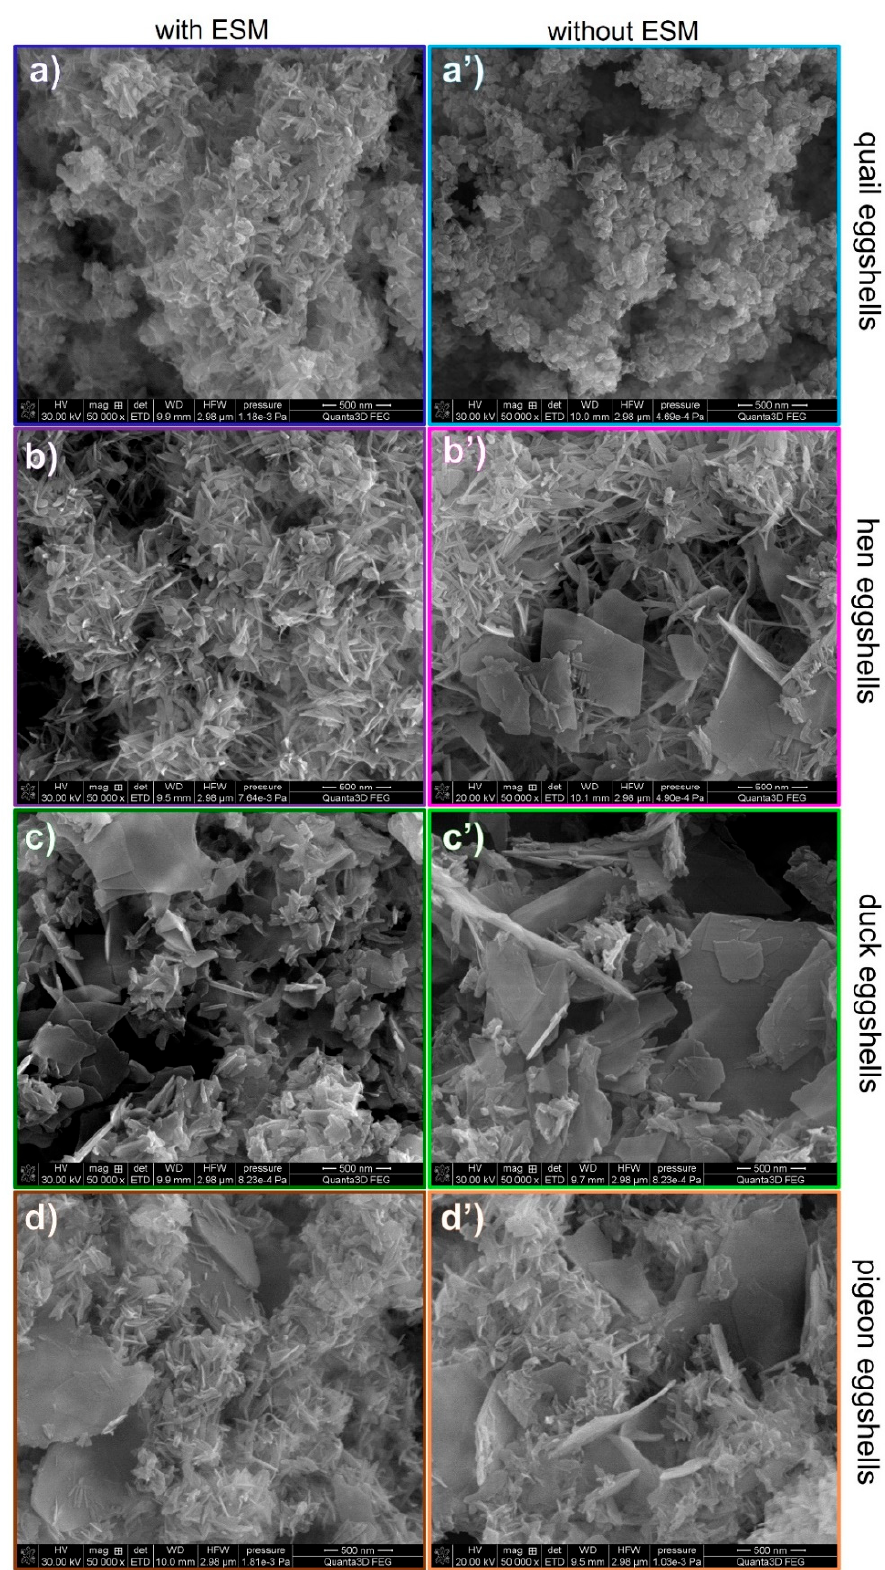
Figure 4. SEM images of the materials derived from different poultry eggshells with ( a – d ) and without ( a’ – d’ ) an EMS.